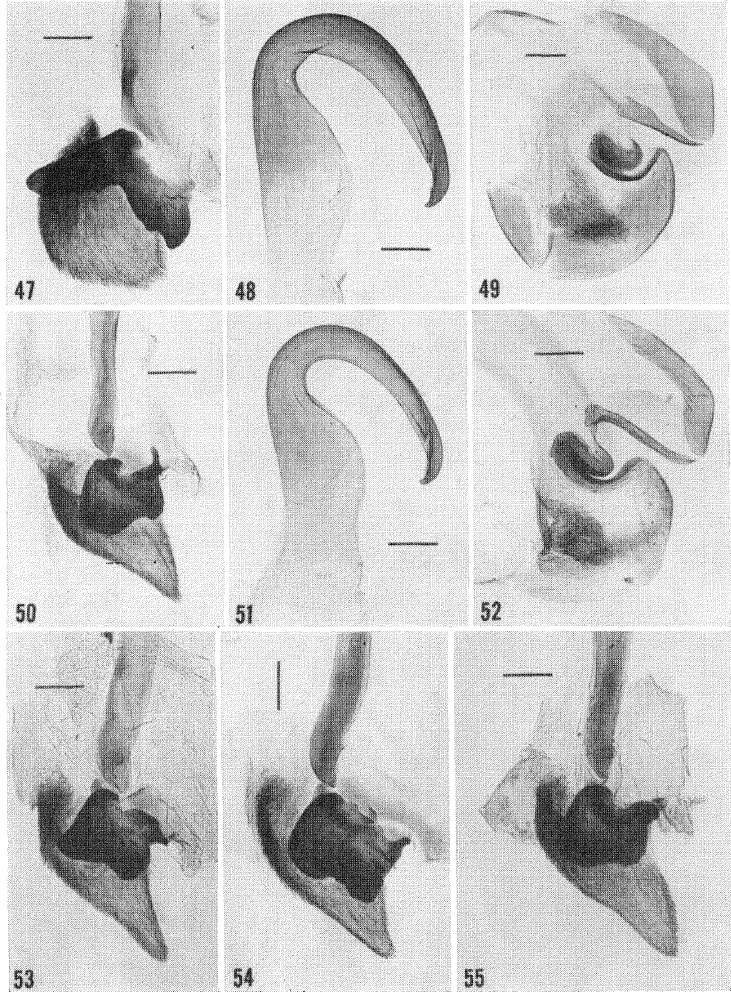
Figs. 4.7-55. Cockroach male genitalia. 47-49. (158 USNM). Epilampra maya. Boston Quarantine (det. Roth). 50-55. Epilampra abdomenni.c/rum. 50-52. (101 USNM). Puerto Rico (det. Roth). 53. (71 MCZ). British Guiana. 54. (163 USNM). Essequebo River, British Guiana (det. Roth). 55. Le Moule, Guad,e’loupe (det. Bonfils). (scale 0.2